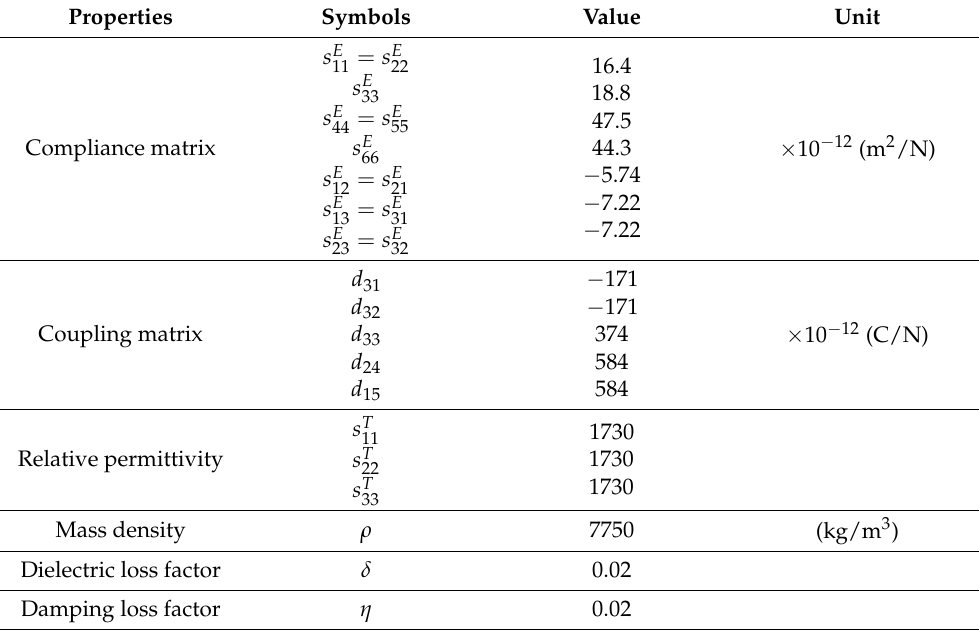
Table 2. The piezoelectric properties of the PZT